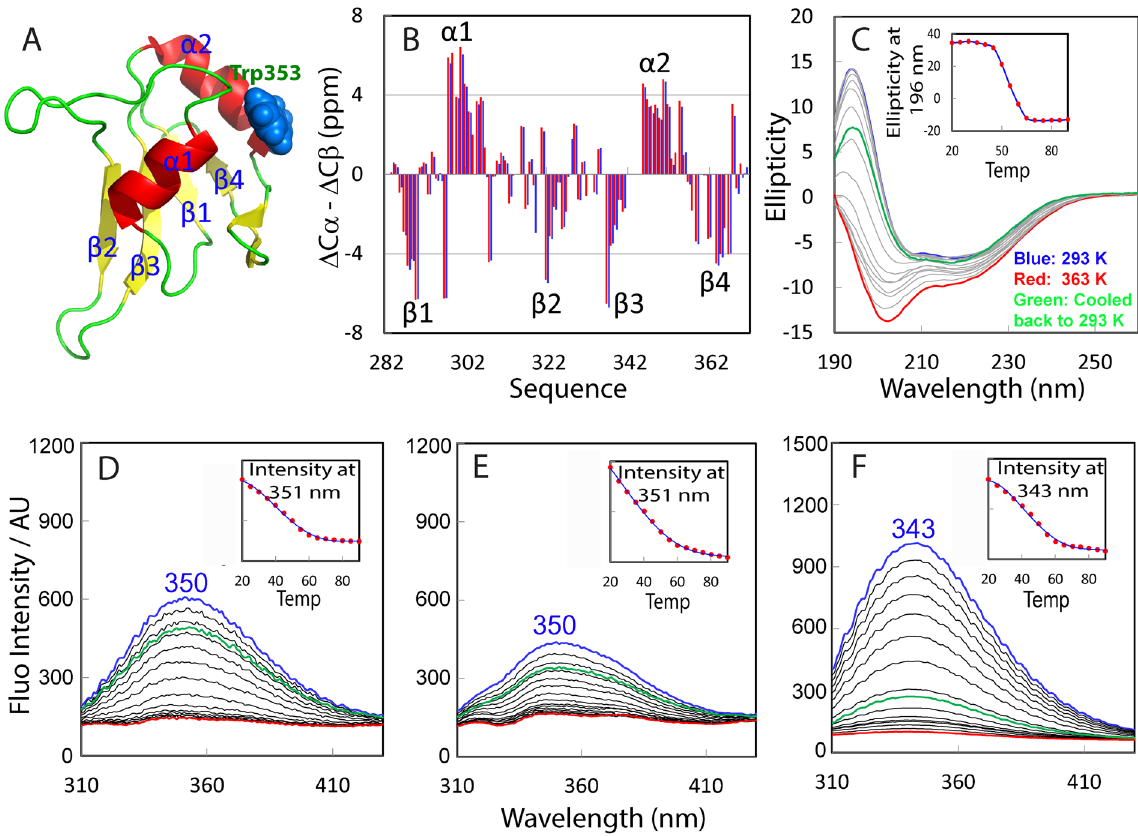
Figure 5. Thermal unfolding of the FUS RRM domain. ( A ) NMR structure of the FUS RRM domain (pdb ID of 2LCW), with secondary structures labelled and Trp353 residue displayed in spheres. ( B ) Residue specific ( Δ C α − Δ C β ) chemical shifts of the FUS RRM domain collected at 25 °C in 10 mM phosphate buffer at pH 6.8 (blue) and those previously deposited in BMRB (ID of 17635) (red). ( C ) Far-UV CD spectra of the FUS RRM domain at a concentration of 40 µ M in 1 mM phosphate buffer at pH 6.8 with temperatures ranging from 20 to 90 °C. Inlet: The thermal unfolding curve as reported by the changes of ellipiticity at 196 nm. Intrinsic UV fluorescence spectra of the FUS RRM domain at a concentration of 40 µ M in 1 mM phosphate buffer at pH 6.8 ( D ); at a concentration of 40 µ M in 10 mM phosphate buffer at pH 6.8 ( E ); and at a concentration of 100 µ M in 10 mM phosphate buffer at pH 6.8 ( F ) with temperatures ranging from 20 to 90 °C. The fluorescence intensity was reported in arbitrary unit. Inlets: The thermal unfolding curves as reported by the changes of fluorescence intensity at the wavelengths of the emission